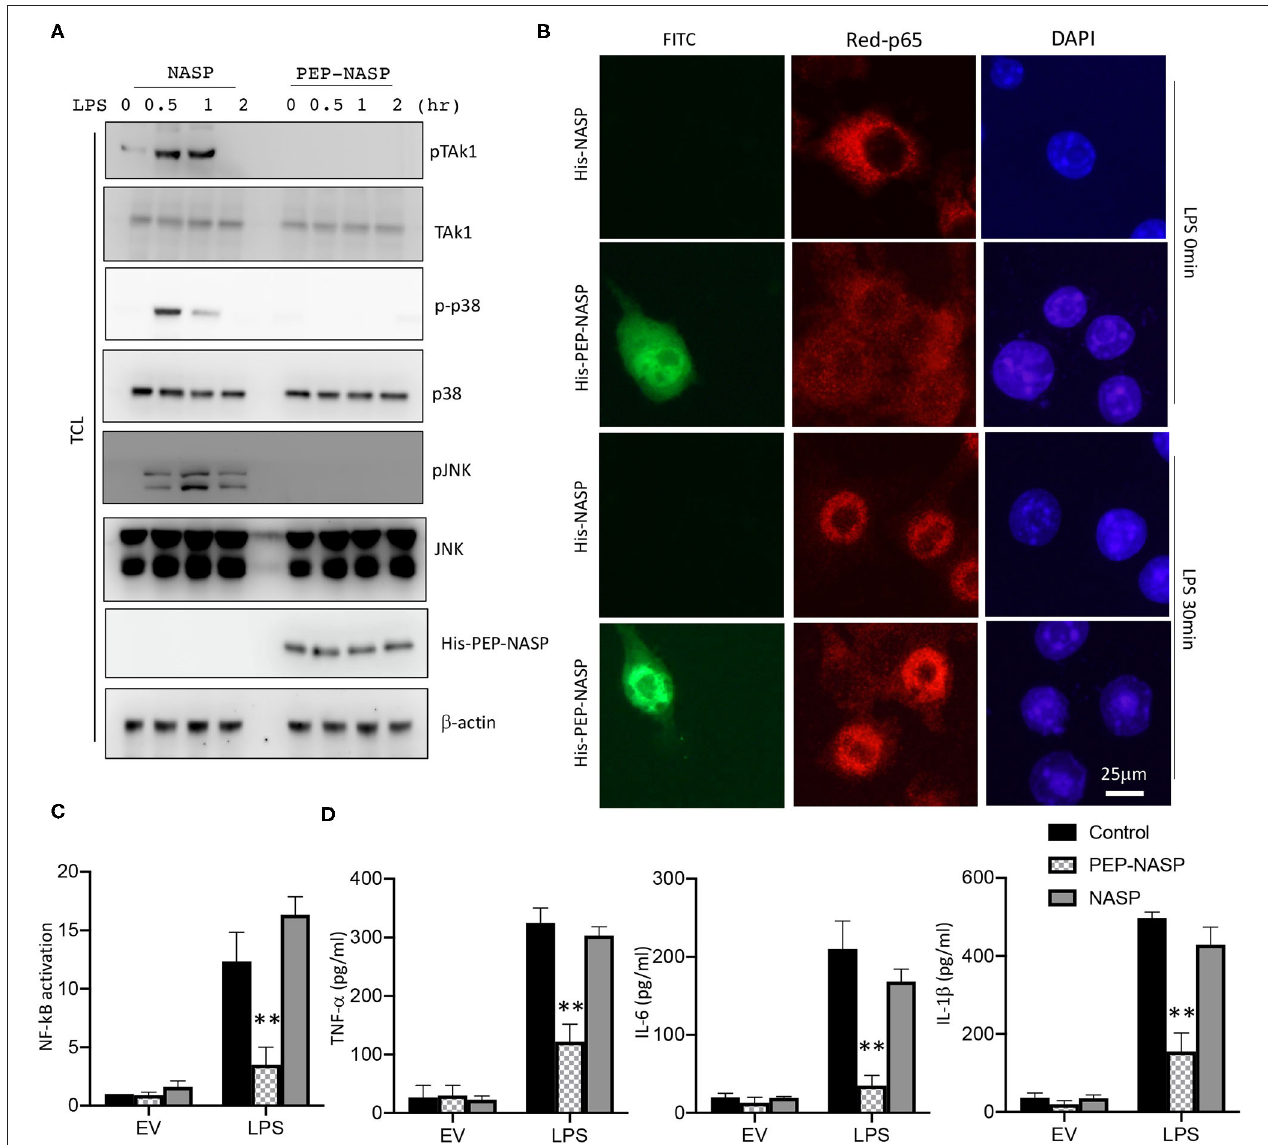
FIGURE 4 | The PEP-NASP inhibited LPS-induced activation of NF- κ B and expression of proinflammatory cytokine production in macrophages. (A) RAW 264.7 cells pretreated with the PEP-NASP or NASP were stimulated with LPS for different time points and assessed by an immunoblotting (IB) analysis with the indicated antibodies. (B) FITC-labeled PEP-NASP or NASP was transduced into RAW 264.7 cells. After 48h, cells were fixed and immunostained with an anti-p65 (Red) antibody. Nuclei were counterstained with DAPI. Images were visualized by confocal microscopy. Scale bar = 25 µ m. (C) Luciferase activity in RAW 264.7